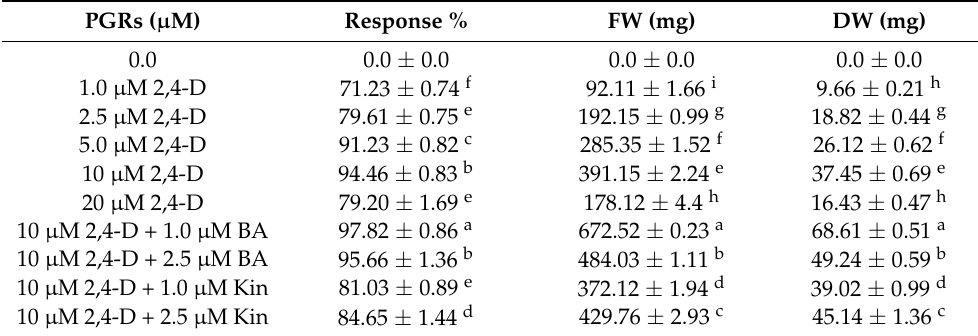
Table 1. Effect of 2,4-D alone or in combination with BA or Kin on callus induction, fresh, and dry weight of callus from internodes after 6 weeks of culture.